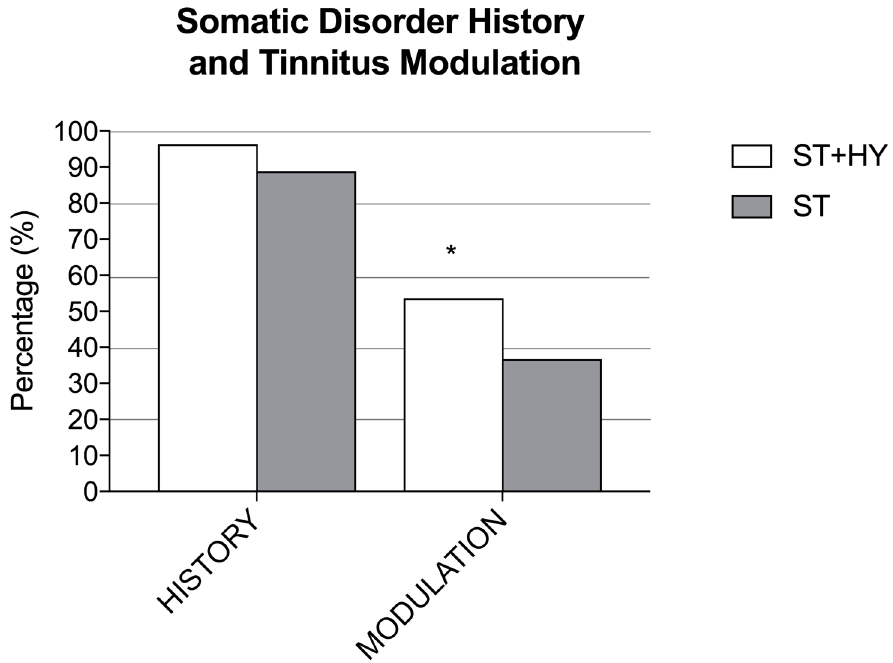
Fig 2. Somatic disorder history and tinnitus modulation. Percentages of somatic disorderhistory and somatic tinnitus modulation ability in somatic tinnitus patients with (ST+HY) and without (ST) hyperacusis. Comparedto the ST group, significantly more patients in the ST+HY group could somatically modulate their tinnitus (p < 0.001).No significantdifferences in history were found (p = 0.64).